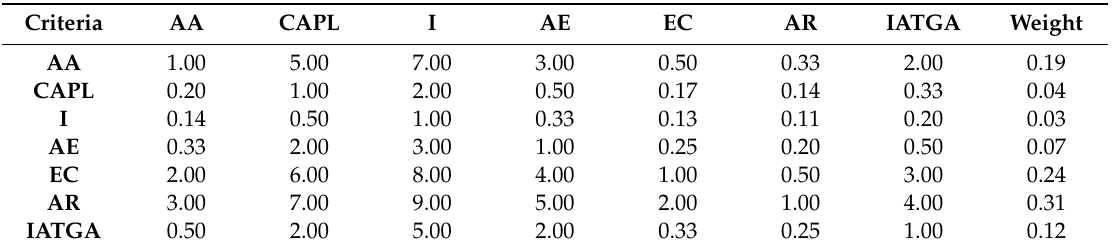
Table 3. Analytical hierarchy process (AHP) pairwise comparison matrix for AWP index for the West Bank case study.